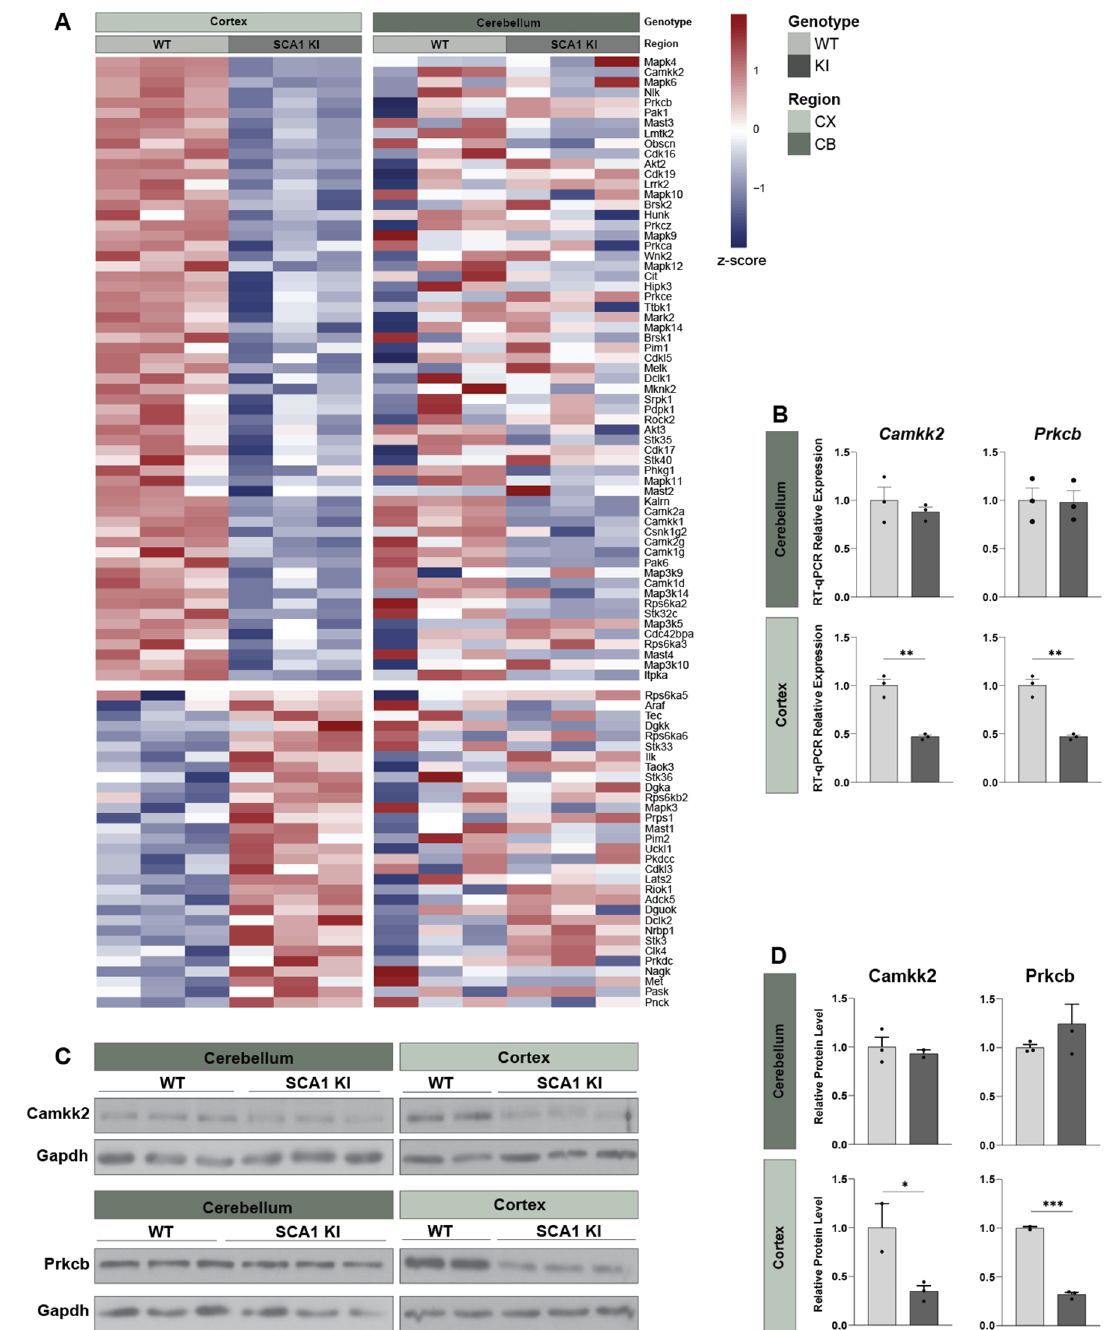
Figure 5. Cortex-specific downregulation of kinases in SCA1 KI mice. ( A ), Heatmap of downregulated (top panel) and upregulated (bottom panel) serine-threonine kinases (GO Term GO:0106310) in the SCA1 KI mouse cortex (left panel), relative to WT littermate controls, showing no consistent up- or down-regulation in the SCA1 KI mouse cerebellum (right panel). Cell color indicates Z-score scaled by row and region. ( B ), RT-qPCR validation of Camkk2 and Prkcb mRNA expression levels in the 12-week SCA1 KI mouse cerebellum and cortex, normalized to housekeeping genes Gapdh, Hprt, and ActB , relative to WT littermate controls. ( C ), Western blot images of Camkk2 and Prkcb, with Gapdh as a loading control using the 12-week SCA1 KI mouse cerebellar or cortical protein extracts, quantified in ( D ). ( D ), Relative protein level of Camkk2 and Prkcb in the 12-week SCA1 cerebellum and cortex, normalized to Gapdh and relative to WT littermate controls (n = 3 per genotype). (* p < 0.05, ** p < 0.01, *** p < 0.001).